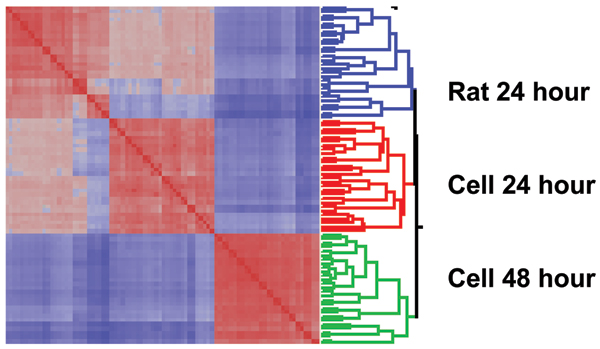
Hierarchical clustering analysis of the correlation matrix of normalized data. Blue squares represent low correlations and red represents high correlations.